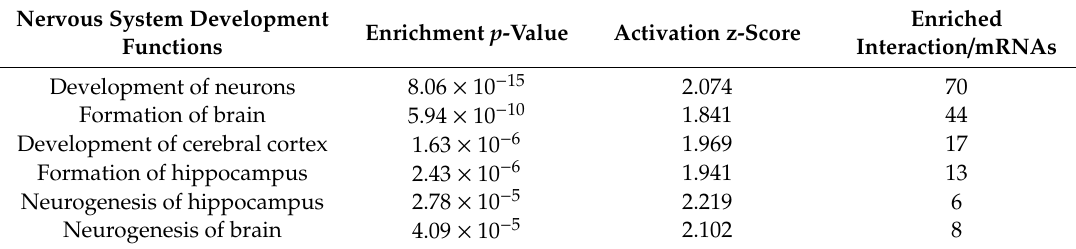
Table 1. The nervous system development functions that were significantly enriched and predicted to be upregulated in 513 miRNA–mRNA interactions identified in iPSCs and their di ff erentiated